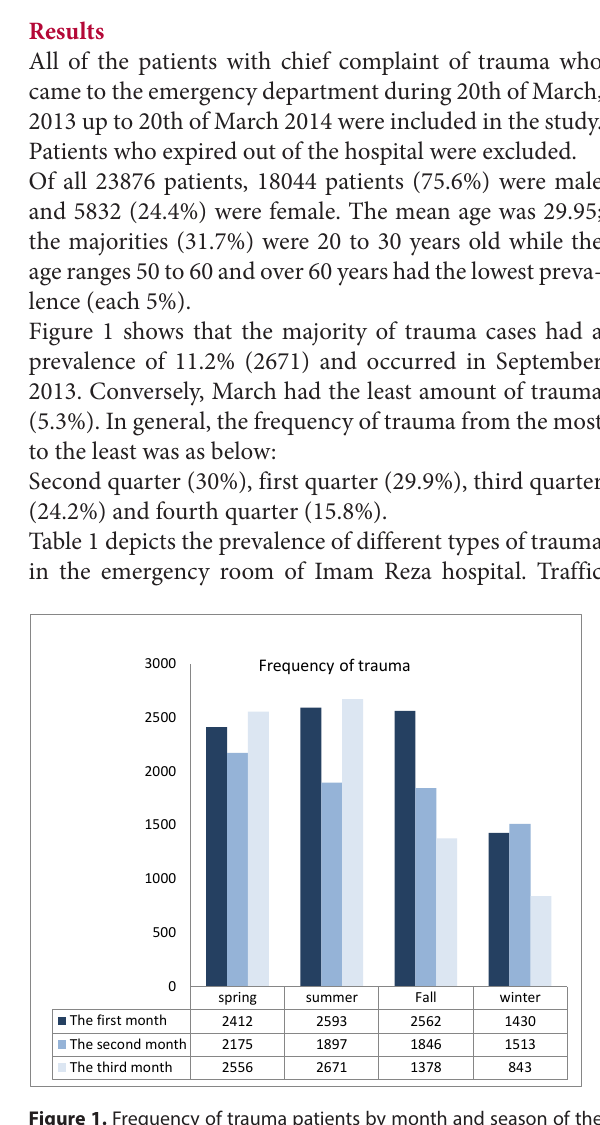
Figure 1. Frequency of trauma patients by month and season of the year.